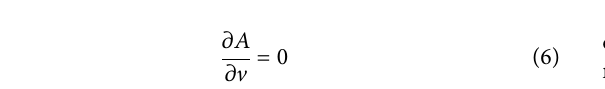
Frontiers in Earth Science |